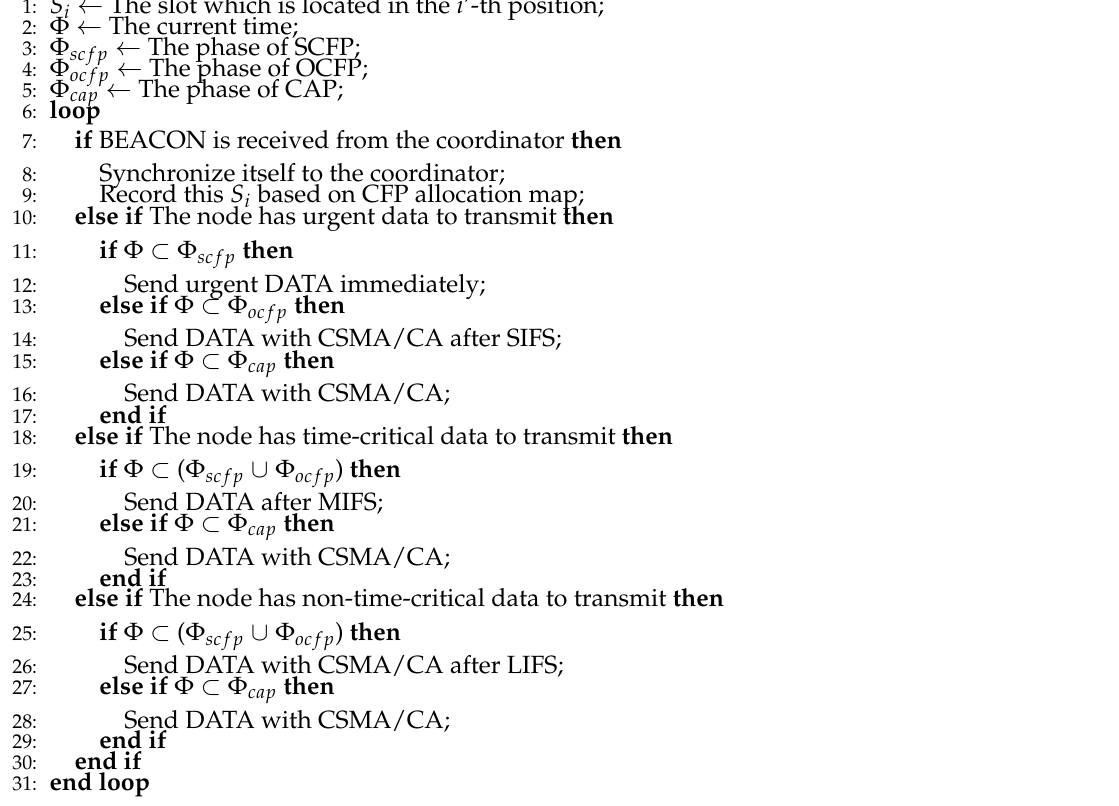
Algorithm 2 The CoR-MAC algorithm for the